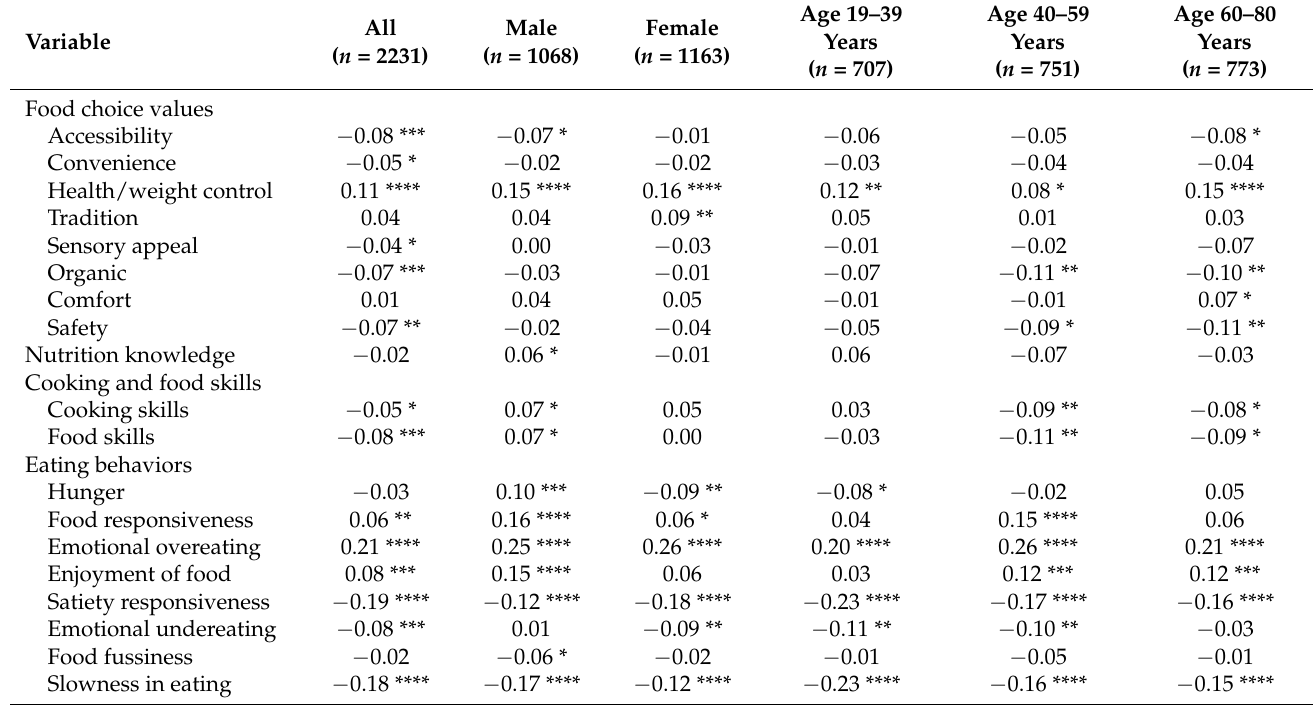
Table 4. Pearson correlation coefficients of body mass index with each of the food choice values and food literacy variables characterized by nutrition knowledge, cooking and food skills, and eating behaviors 1